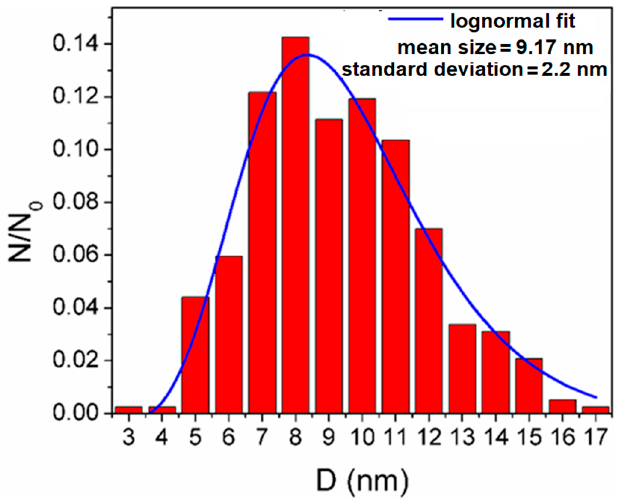
Figure 4. The size distribution of iron-oxide nanoparticles on 336 particles from 14 different TEM pictures.